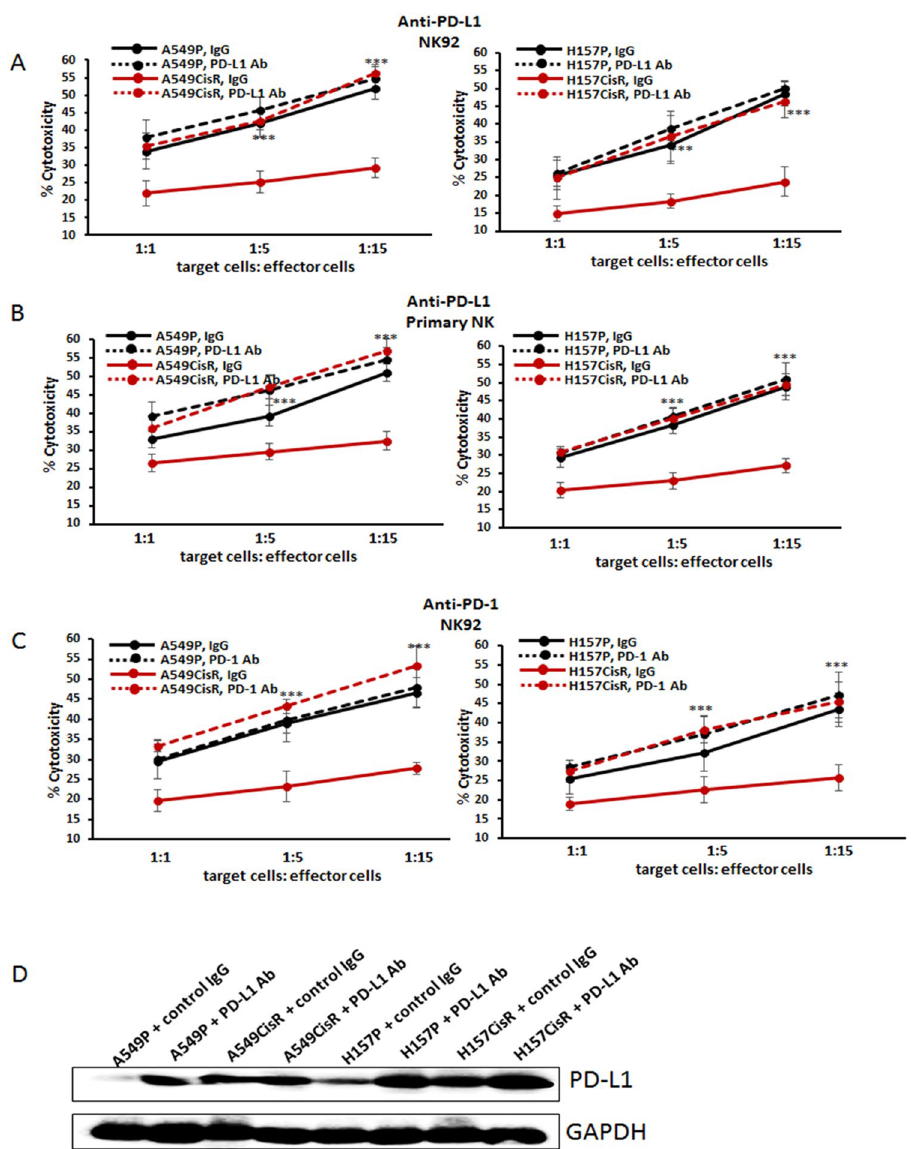
Figure 4. Effects of neutralizing Abs of PD-L1 or PD-1 on the susceptibilities of cisplatin-resistant lung cancer cells to NK cell cytotoxicity. ( A , B ) NK cytotoxicity tests to A549P/A549CisR and H157P/H157CisR cells upon addition of anti-PD-L1 Ab to tumor cell/NK cell co-culture. ( A with NK92 cell line; B with primary NK cells) ( C ). NK cell cytotoxicity tests to A549P/A549CisR and H157P/H157CisR cells upon addition of anti-PD-1 Ab to tumor cell/NK cell co-culture (with NK92 cells). ( D ) Western blot analyses showing PD-L1 levels in A549P/A549CisR and H157P/H157CisR cells after incubation with either control IgG or PD-L1 Ab. * p < 0.05, ** p < 0.01, *** p <